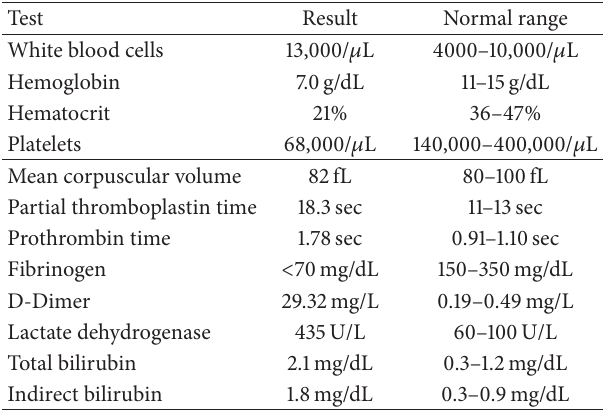
Table 1: Laboratory values at